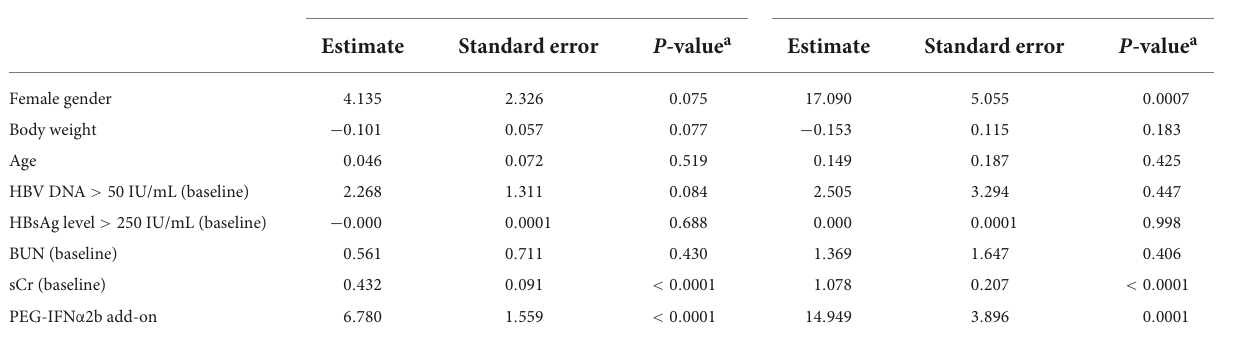
a Resultsfromthelinearmixedeffectsmodelforrepeatedmeasures. TABLE 3 Predictors for eGFR changes at 48 weeks of therapy.